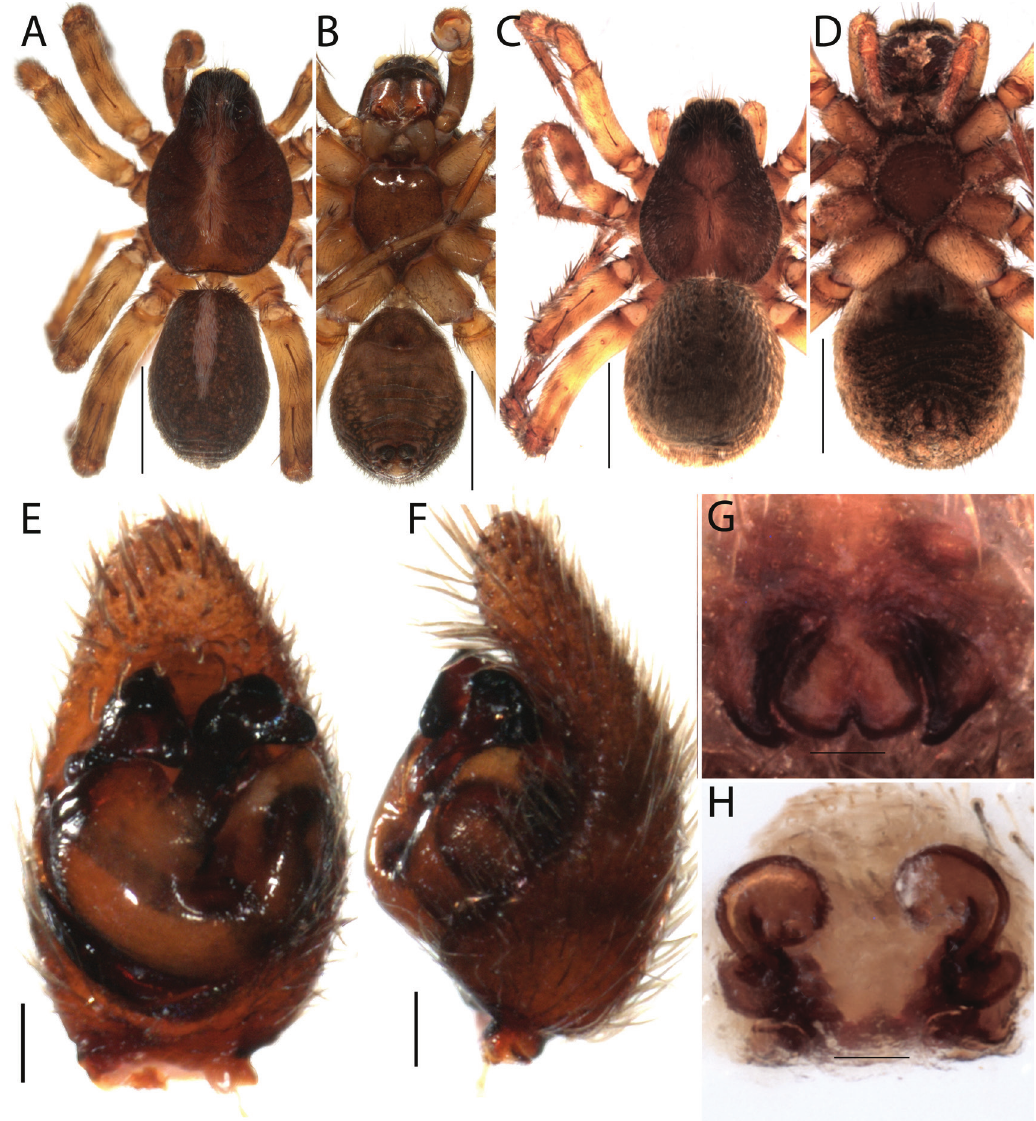
Figure 14. Artoria corowa sp. n., male holotype (AM KS128079), female paratype (AM KS76583): A , male habitus, dorsal view; B , male habitus, ventral view; C , female habitus, dorsal view; D , female habitus, ventral view; E, male pedipalp, ventral view; F , male pedipalp, retrolateral view; G , epigyne, ventral view; H , epigyne, dorsal view. Scale bars: habitus 1.0 mm; pedipalp, epigyne 0.1